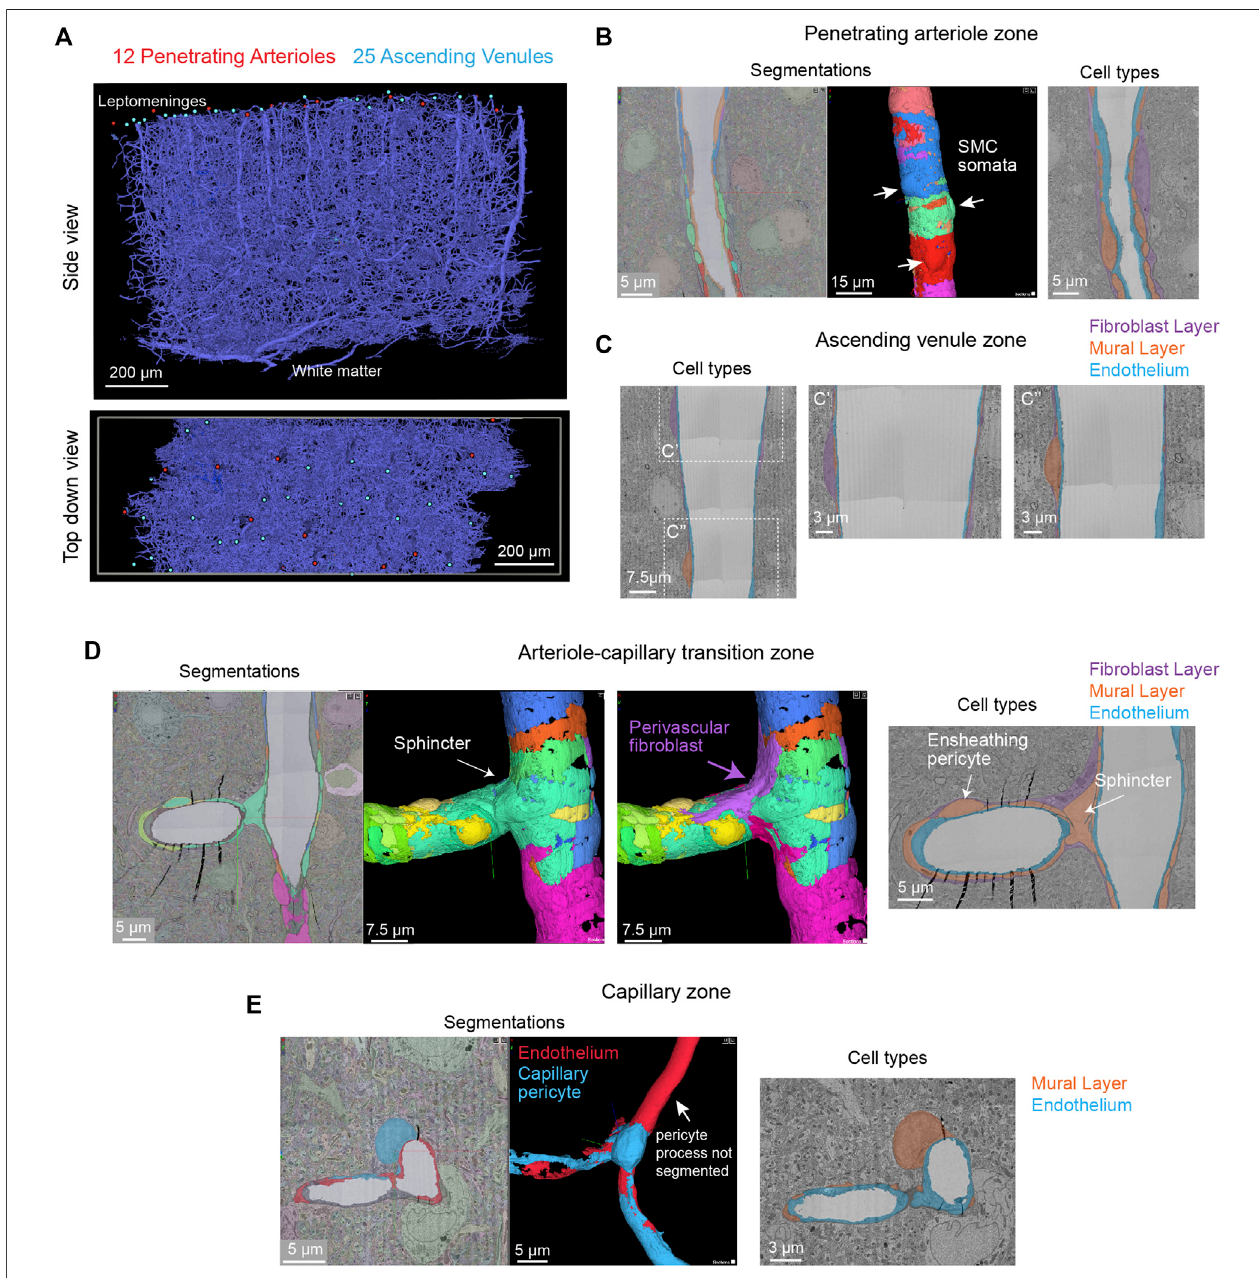
FIGURE 7 | All vascular zones are represented in the MICrONS Cortical MM ^ 3 data set. (A) The vasculature captured includes 12 penetrating arterioles, 25 ascending venules, and extensive intervening capillary networks. The bottom panel shows a top-down view of the volume and reveals the originating position of penetrating vessels at the pial surface. Link to annotations: https://ngl.microns-explorer.org/#!gs://microns-static-links/mm3/vascular_annotation.json. (B) A penetrating arteriole with some smooth muscle cells selected for 3D viewing (arrows). On the right, the three distinct cell types that make up the vascular wall (endothelialcells, mural cells, and perivascular fi broblasts)areshown throughmanual labeling. MICrONSCorticalMM ^ 3x, y,z coordinates at:225166,107266, 18188. (C) An ascending venule exhibits a vascular wall that is thinner than the arteriole, but still contains endothelial cells, mural cells, and perivascular fi broblasts. These cell types were not well separated by segmentation and therefore only manual labeling of these cell layers is shown. Coordinates at: 262168, 104664, 24791. (D) The arteriole-capillary transition zone is a small segment of vasculature that intervenes between the penetrating arteriole and true capillary bed. The endothelium, mural cells (sphincter cell and ensheathing pericyte), and perivascular fi broblasts are generally segmented in this region of interest. Here, we show the mural cell layer (left and middle) which involved cobbling of many separately segmented structures to visualize the overall morphology of the sphincter cell and ensheathing pericyte. The sphinctercellwasclassi fi edbasedonpriordescriptionsbyGrubbetal . showingacuff-likecellatthepenetratingarteriolejustbeforebranchingintothetransitionalzone, with local decrease in vessel diameter. On the right, we add a perivascular fi broblast, which may not have been captured in entirety but shows feasibility of its separate segmentation. Onthe right, thelocationofdifferentcell layersisshown throughmanuallabeling.Coordinates at: 168985,165246, 19171. (E) Thecapillarywall consists